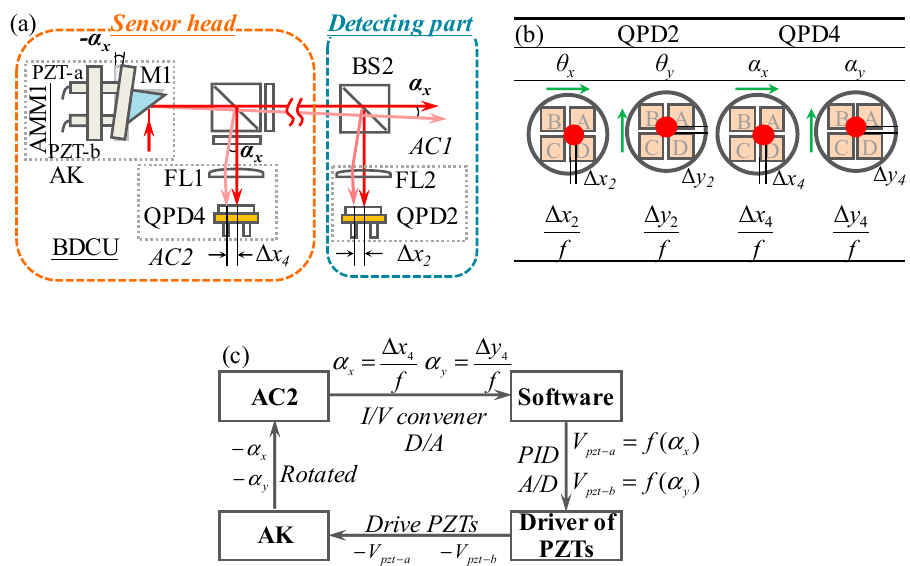
Figure 3. Measurement principle of the pitch and yaw angular errors: ( a ) Optical layout of pitch and yaw angular errors measurement kit, ( b ) variations of laser beam positions on QPDs, ( c ) procedure of compensating the drifted angular errors.